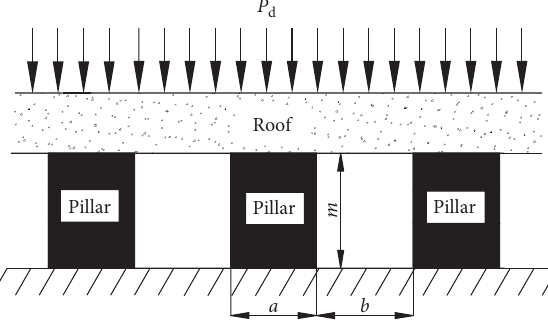
Figure 1: Mechanical model of the coal pillar